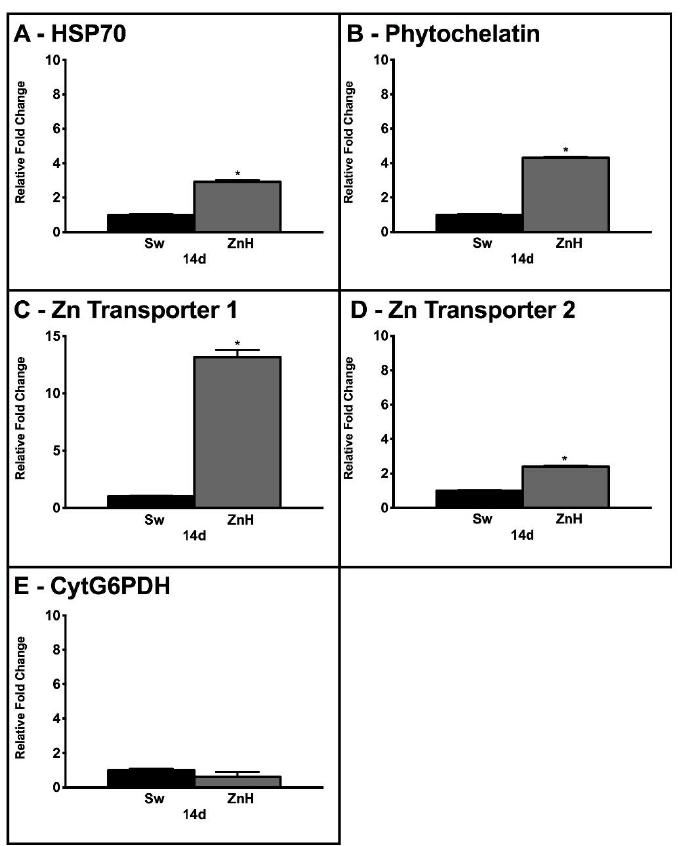
Figure 4. Gene expression levels of HSP70 ( A ), phytochelatin ( B ), Zn transporter 1 ( C ), Zn transporter 2 ( D ) and cytG6PDH ( E ) after 14 days in Sw (black bars) and ZnH (grey bars) conditions, measured by qRT-PCR. Variations are indicated as relative fold change in ZnH with respect to respective controls (Sw). mRNA levels were calculated relative to the expression of the RNA GAPDH, used as a calibrator. Asterisks indicate significantly different values at p ≤ 0.05 (*).